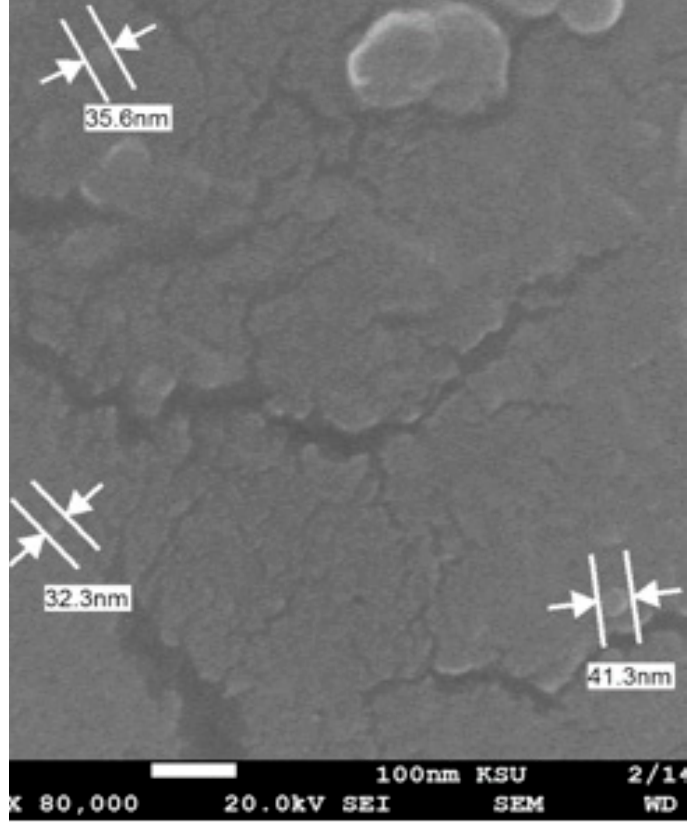
Figure 5. SEM micrograph of AgNPs prepared with aqueous A . nilotica pod extract.